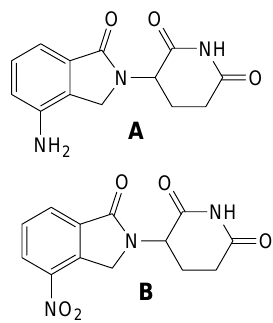
Figure 1. Chemical structures of lenalidomide and its